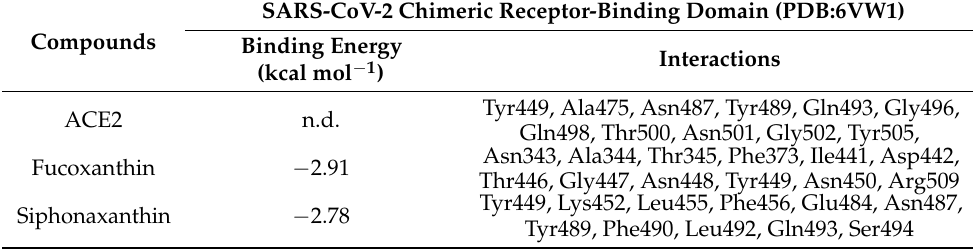
Table 1. Interaction and binding energy of ligands with SARS-CoV-2 chimeric receptor-binding domain (RBD) in silico.